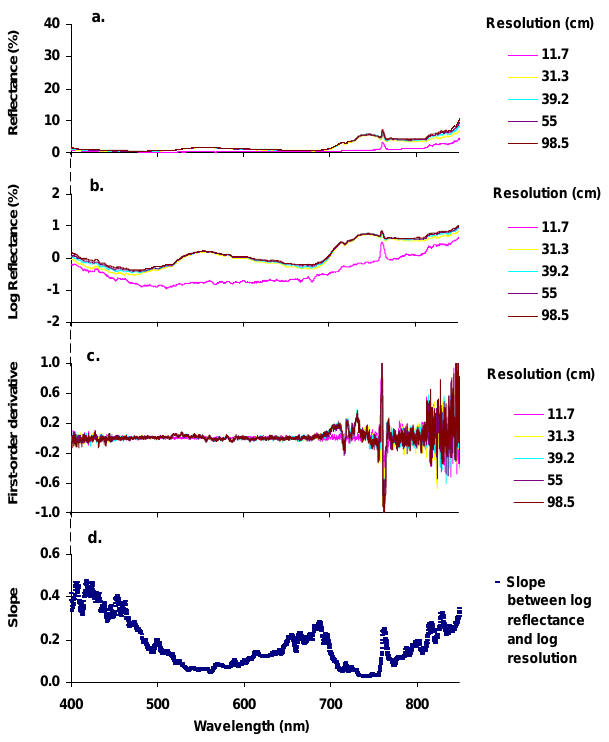
Fig. 2. Data obtained in 12 August 2007, in site 106, using the Fig. 2 – Data obtained in July August 12, in site 106, using the wavelength range of 400- wavelength range of 400–850nm, at various spatial resolutions; 850 nm, at various spatial resolutions; a. Reflectance. b. Log reflectance. c. First-order derivative. d. slope between log reflectance and log resolution.